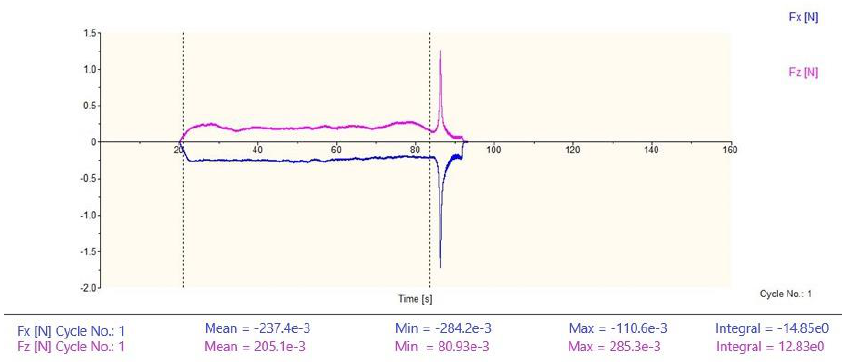
Figure 5. Cutting force measurement